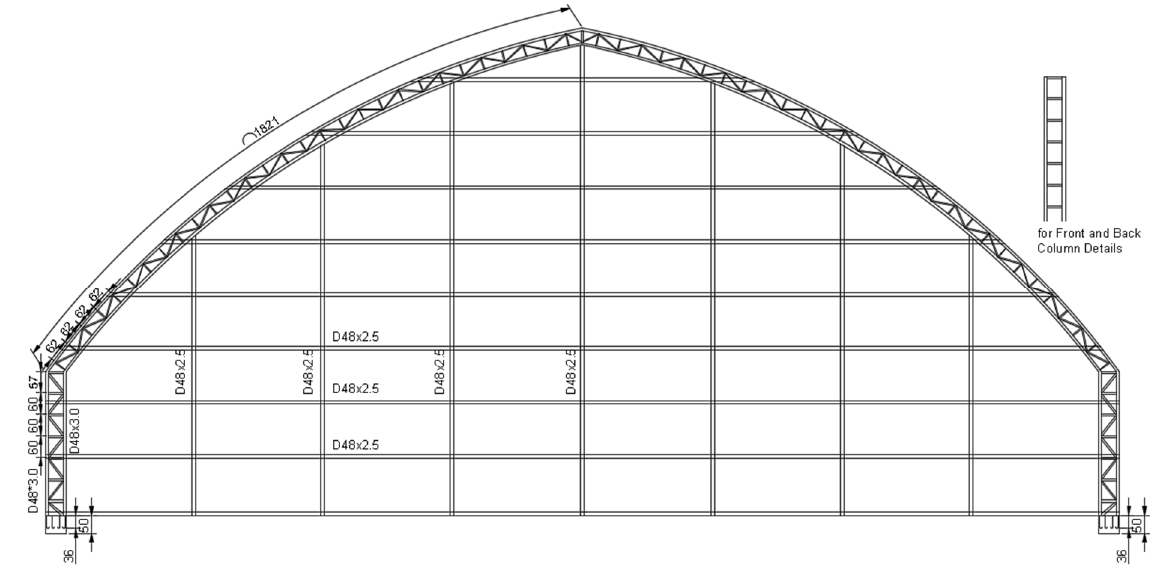
Figure 1. The sectional view of the structures.